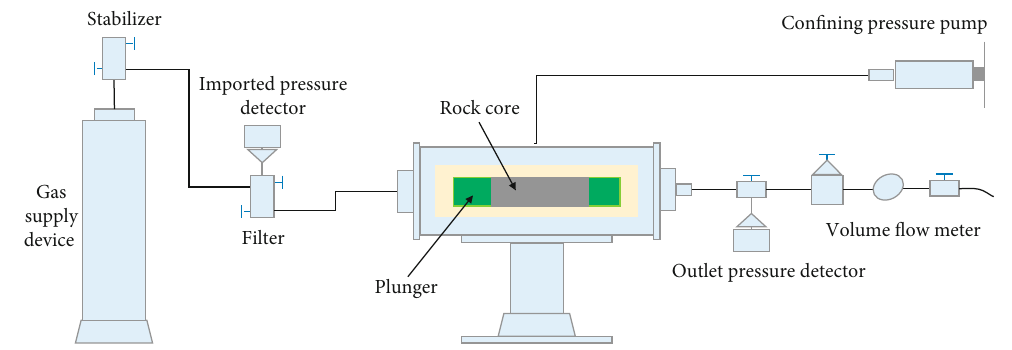
Figure 2: Experimental fl